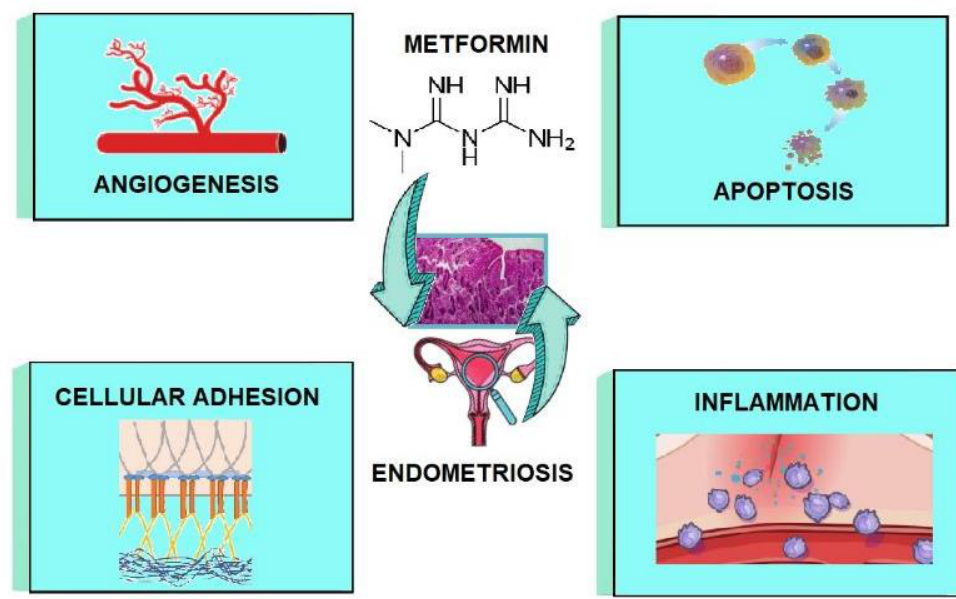
Figure 1. The potential actions of metformin in endometriosis.